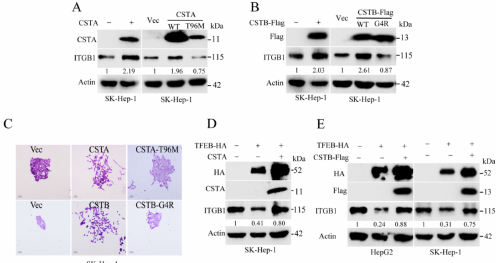
Figure 6. Lysosomal proteinase inhibitors CSTA and CSTB suppress the turnover of ITGB1. ( A ) SK- Hep-1 cells expressing either CSTA or CSTA T96M were subjected to Western blotting analysis. ( B ) SK- Hep-1 cells expressing CSTB-Flag or CSTB G4R -Flag were subjected to Western blotting analysis. ( C ) SK-Hep-1 cells expressing CSTA or CSTA T96M or CSTB-Flag or CSTB G4R -Flag were subjected to colony formation analysis. ( D ) SK-Hep-1 cells expressing TFEB were infected with lentivirus encoding CSTA, then subjected to Western blotting analysis. ( E ) HepG2 or SK-Hep-1 cell expressing TFEB were infected with lentivirus encoding CSTB-Flag, then subjected to Western blotting